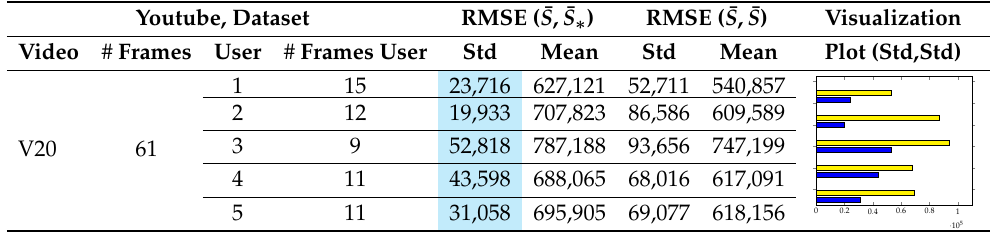
Table 4. Descriptive statistics with RMSE ( ¯ S , ¯ S ∗ ) (target summary against random uniform sample) and RMSE ( ¯ S ∗ , ¯ S ∗ ) (random uniform sample against random uniform sample). Lower is better. Sam- pling rate: 1 frame per second. Dataset in [7], videos from V71 to V80. Highlighted values correspond